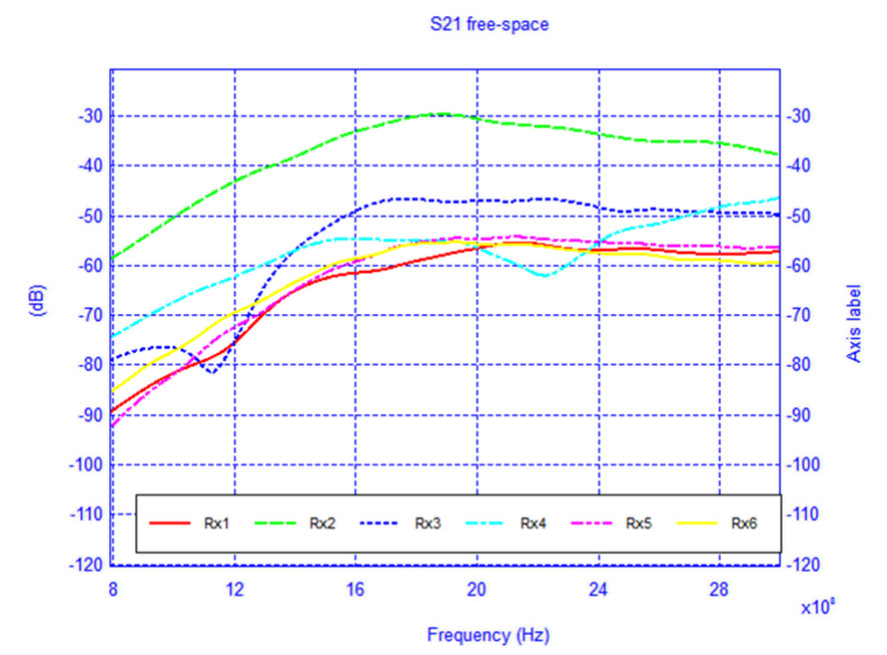
of the BAN network scenario with body Figure 16. S 21